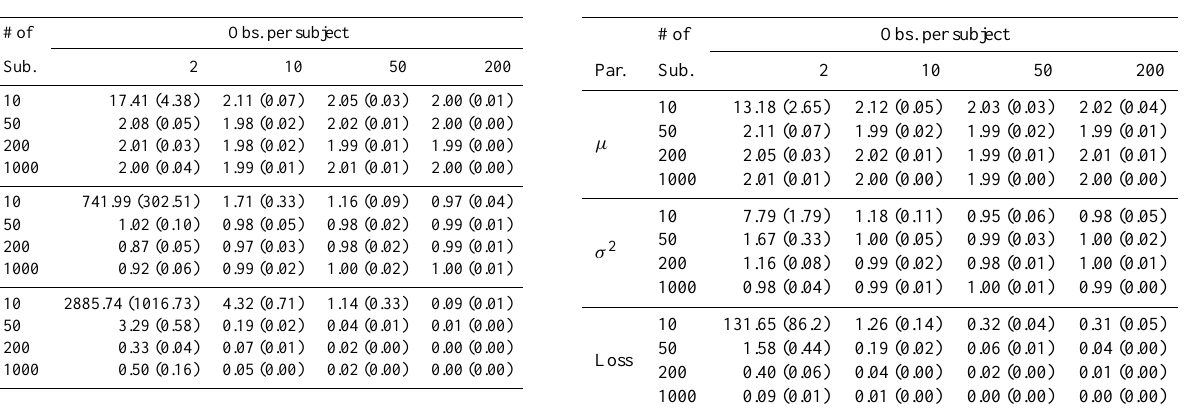
Table 1. MSIM simulation results: µ = 2, σ 2 = 1. Table 2. dclone simulation results: µ = 2, σ 2 =